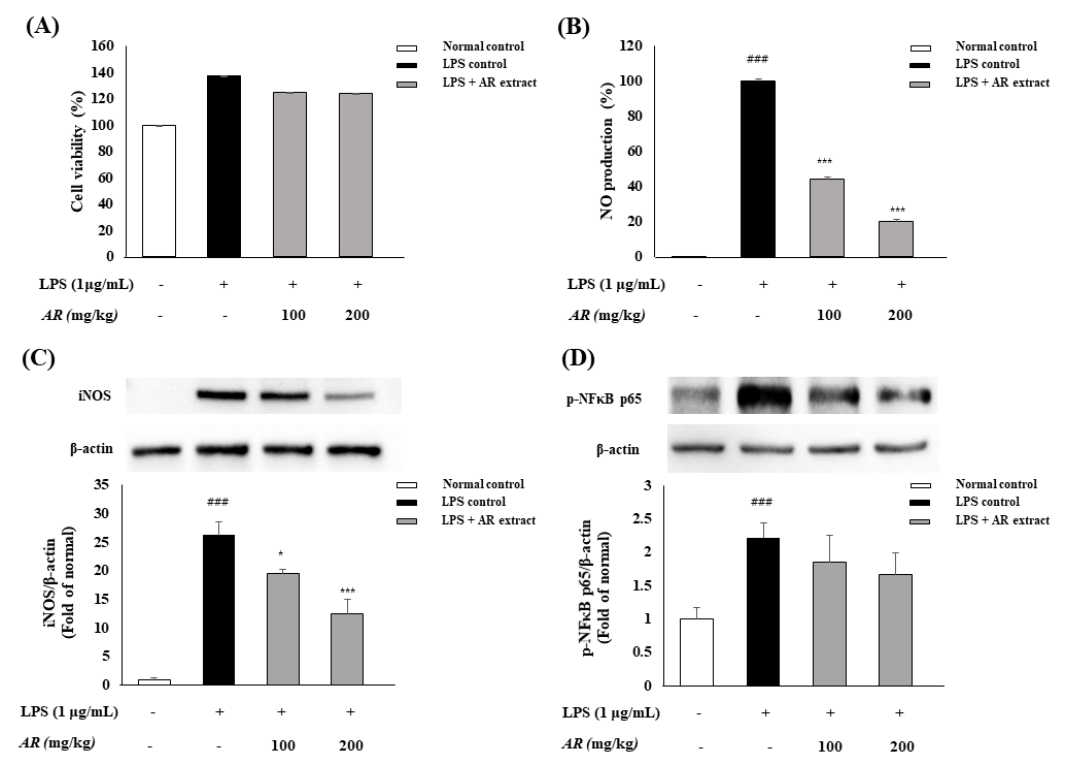
Figure 3. Cell viability ( A ) and NO production ( B ) of LPS (1 μg/mL)-induced RAW 264.7 cells treated with A. rugosa extracts (100 and 200 μg/mL) for 24 h: The expressions of iNOS ( C ) and p-NFκB p65 ( D ) proteins for 1 h after the treatment of extracts with LPS in RAW 264.7 cells. Cell viability was determined using a cytotoxicity assay kit, and NO production was measured using the Griess assay. Expression of inflammatory proteins iNOS and p-NFκB p65 was analyzed by western blot assay. Data are means ± standard deviation (SD); ### p < 0.001 compared with normal control cells; * p < 0.05 and *** p < 0.001 compared with LPS control cells.